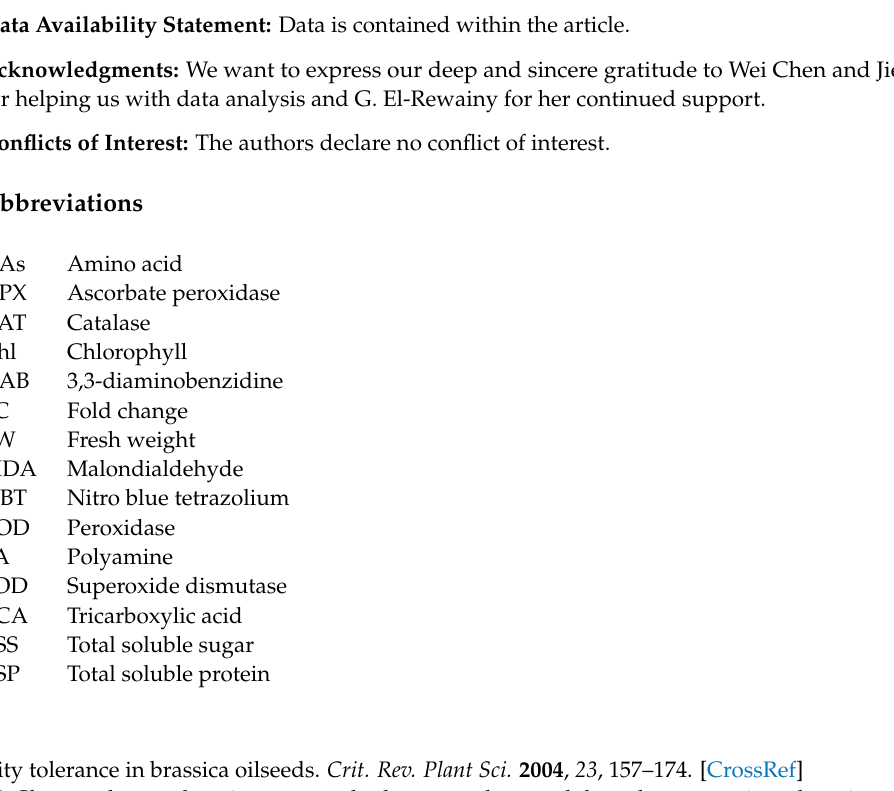
Scoring plot and (d) Loading plot of principal component analysis (PCA) of differential metabolites during 12, 24h of germination upon salt treatment for tolerant cultivar (T) and sensitive cultivar (S), Table S1: Means of FG%, GR, VI (I), and VI (II) of the studied cultivars in the germination stage under salinity stress during the seed germination stage, Table S2: Metabolites differentially accumulated in Yangyou 9 and Zhongshuang 11 seeds under salt stress (150 mM NaCl). Supplementary file (2), Identified metabolites